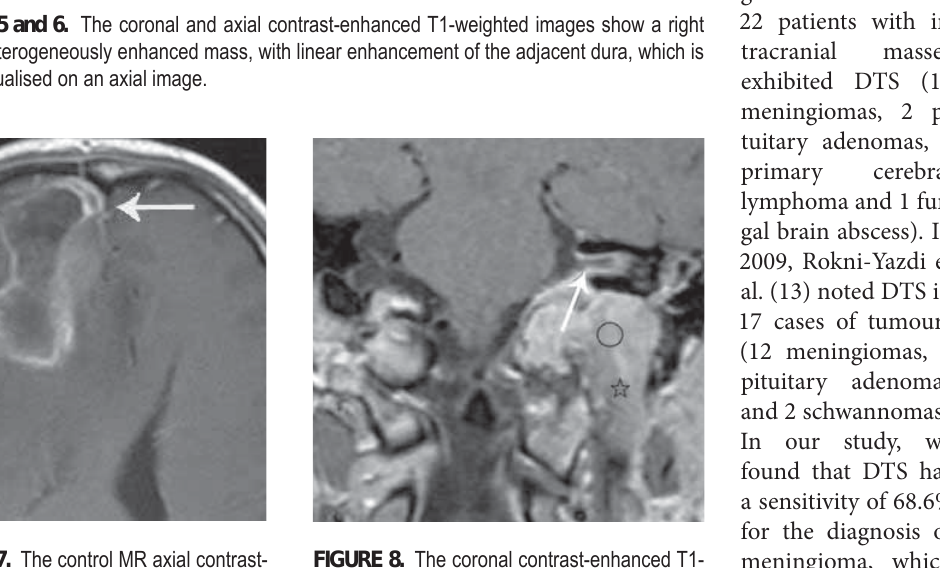
FIGURE 8. The coronal contrast-enhanced T1- weighted image shows intense enhancement in a mass in the left cerebelopontine angle and in the jugular foramen ( circle ), which corresponds to a meningioma. The mass spreads into the in- ternal auditory canal with an evident “dural tail sign” ( white arrow )